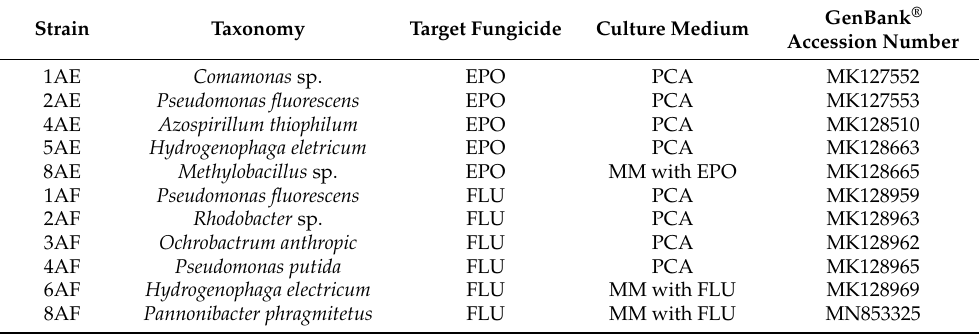
Table 1. Previously isolated bacterial strains used in the optimization trials [7].